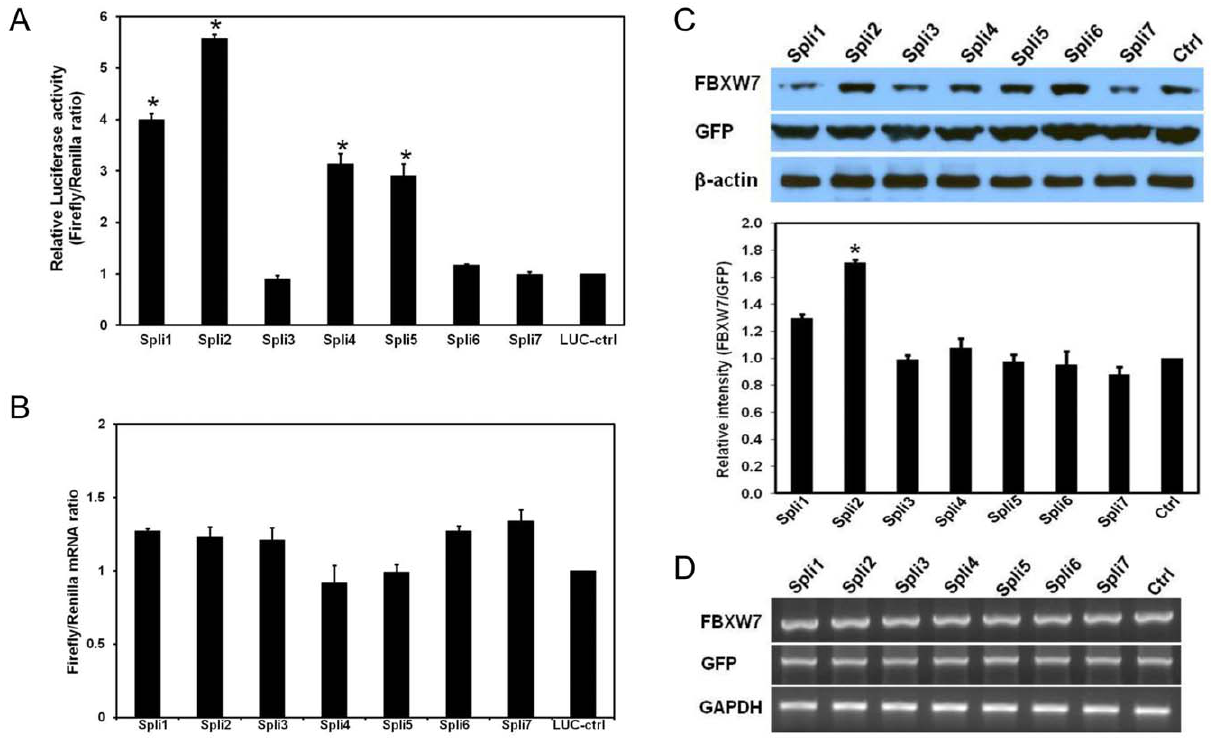
Figure 2. 5 9 -UTRs of FBXW7 a determine the translational efficiency. (A) Effect of FBXW7 a 5 9 -UTR variants on LUC activity. LUC reporter constructs, which contained each FBXW7 a 5 9 -UTR upstream of the LUC reporter gene in the pGL3 vector, were transfected into Hela cells. The LUC activity was measured as the Firefly/Renilla ratio. Results represent the data from three independent experiments. Each experiment was performed in triplicate. Mean data and standard deviations are shown. *p , 0.05 in comparison to LUC-ctr. (B) LUC transcriptional levels were examined by qRT-PCR. The LUC mRNA contents were normalized to the Renilla mRNA contents for all samples and the relative LUC mRNA for pGL3p (empty vector, Promega) was arbitrarily considered to be 1 (control). (C) Effect of 5 9 -UTRs on the FBXW7 a protein levels. Immunoblot was developed with anti-HA antibody from extracts with indicated construct. The intensity of pcDNA3.1( + ) containing FBXW7 a gene (control) was considered as 1. GFP construct was used as transfection efficiency control, and b –actin as loading control. All transfections were performed in triplicate, and the bars indicate the standard deviation. *p , 0.05 in comparison to control. (D) cDNA frangments for FBXW7 (upper panel), GFP (middle panel) and GAPDH (lower panel) were specifically amplified by RT-PCR from Hela cells transfected with indicated